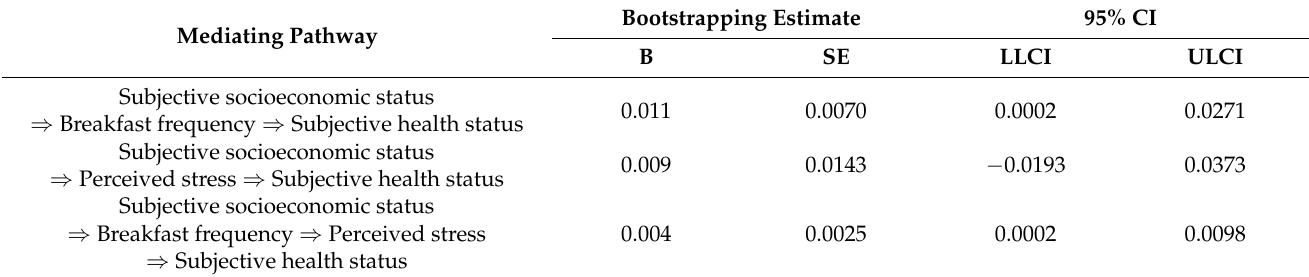
Table 4. The sequential mediating effects among variables by